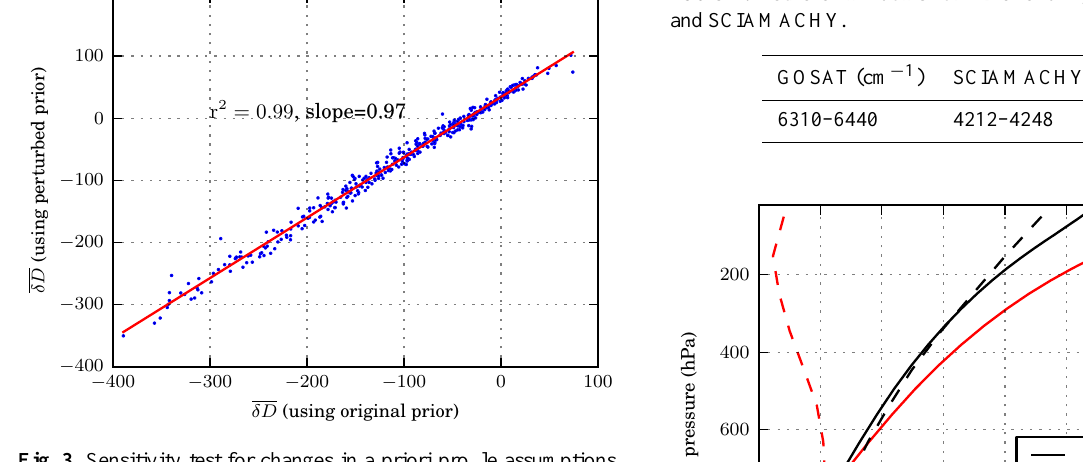
Fig. 3. Sensitivity test for changes in a priori profile assumptions.